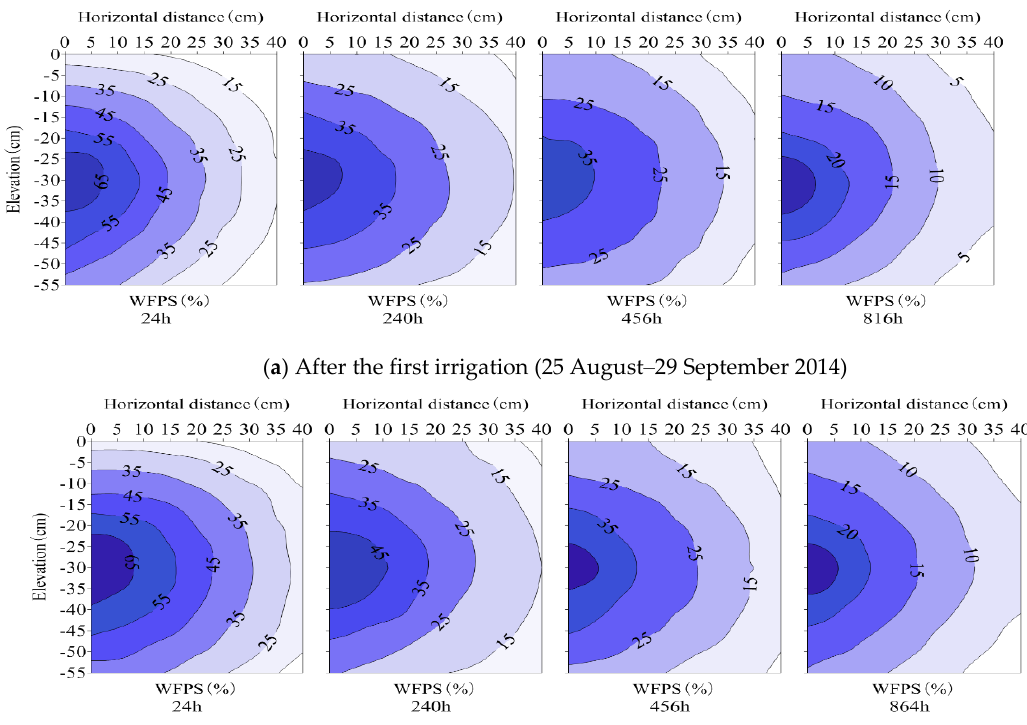
Figure 5. Soil moisture distribution in SDI–3 treatment (surface soil wetting proportion is